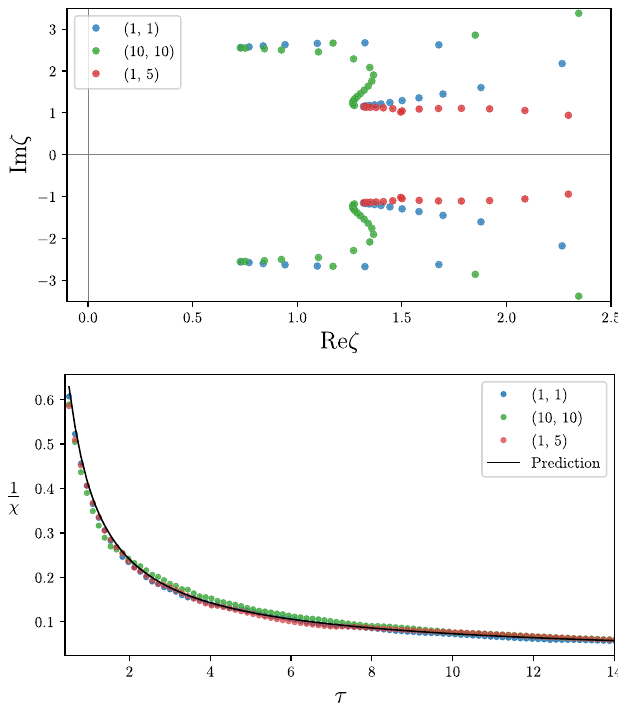
FIG. 6. Singulants in the gradient expansion in RTA kinetic theory in Bjorken flow. Top panel: Borel plane at τ ≈ 0 . 6 for three Þ . One singulant seems to be values of the momentum ð v; p T approximately momentum independent, and is the dominant one. Another depends on their ratio. Bottom panel: test of the singulant equation of motion. χ can be measured numerically at each point in time by calculating the gradient expansion. Alternatively, we can take the dominant singulant from the top panel and evolve it by Eq. (94). The figure shows that these procedures